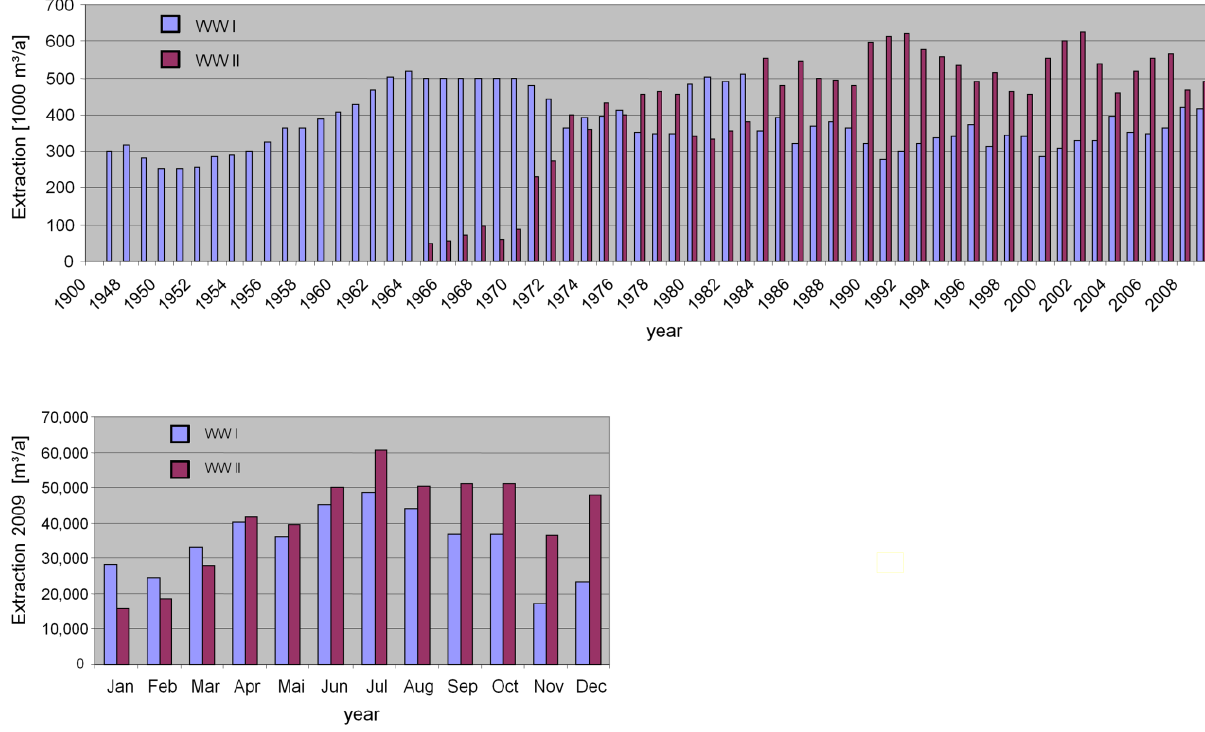
Fig. 2. Top panel: Annual delivery rates [1000m 3 a − 1 ] for WW I (Waterdelle), blue bars, and WW II (Ostland), dark red bars, bottom panel: Figure 2. Top panel: Annual delivery rates [1000 m³/a] for WW I (Waterdelle), blue bars, and 2 monthly delivery rates for WW II (Ostland), dark red bars, bottom panel: monthly delivery rates for 2009. 3